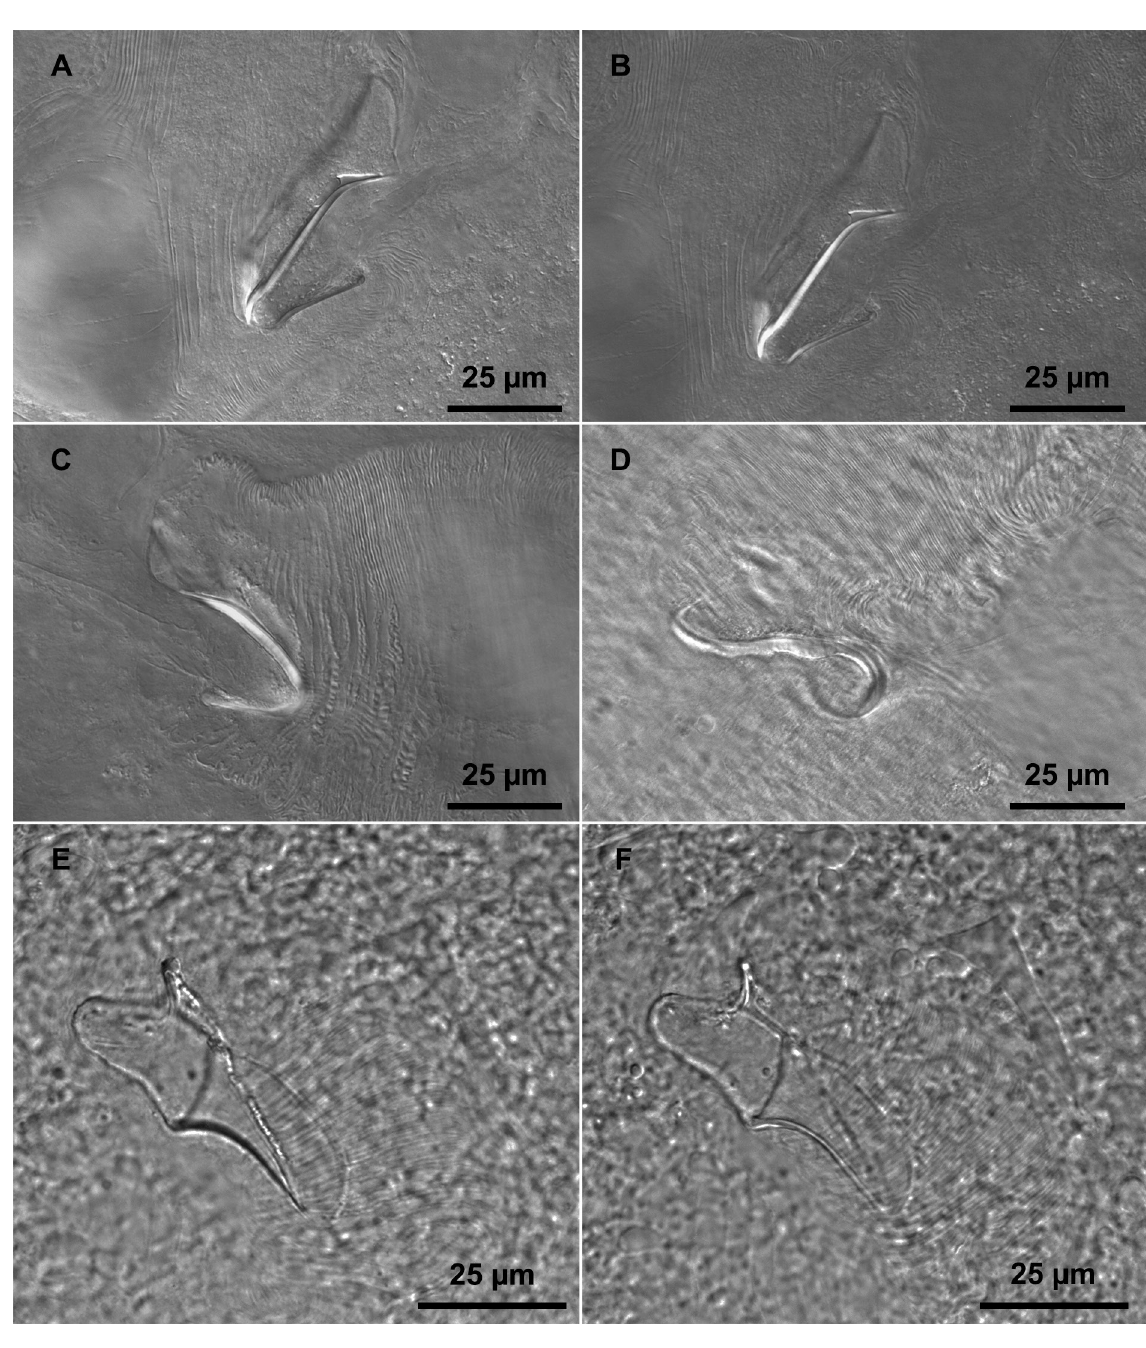
Fig. 3. Species of Typhlopolycystidinae Evdonin, 1977. A–D . Sabulirhynchus axi Artois & Schockaert, 2000 (stylet of the specimens from Panama). E–F . Sabulirhynchus ibarrae sp. nov., prostatic stylet type III from the holotype